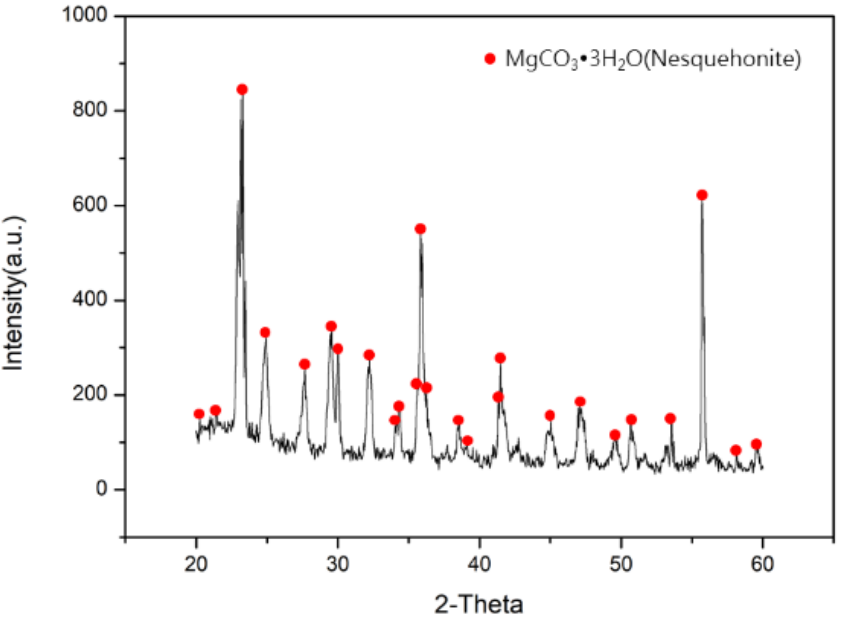
Figure 6. XRD analysis of magnesium carbonate.